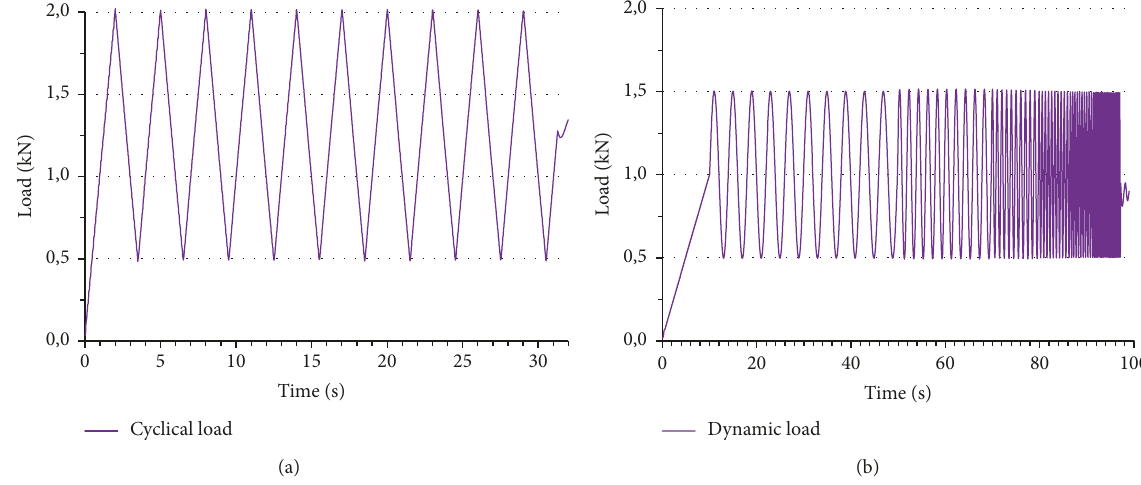
Figure 6: Applied cyclical (a) and dynamic (b) uniaxial loads for electromechanical tests.